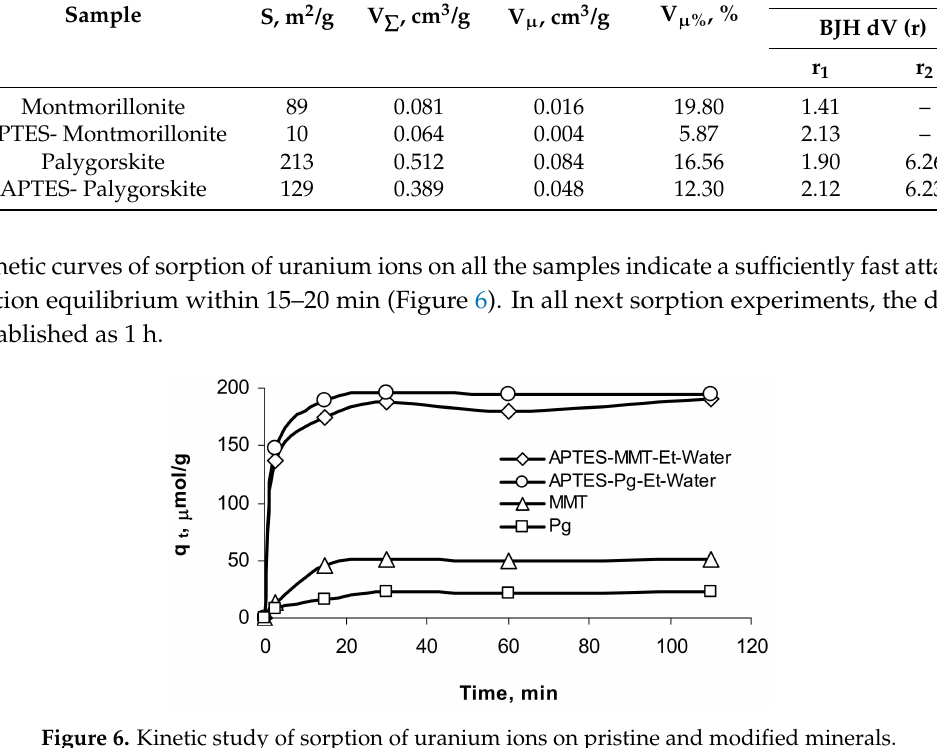
Figure 6. Kinetic study of sorption of uranium ions on pristine and modified